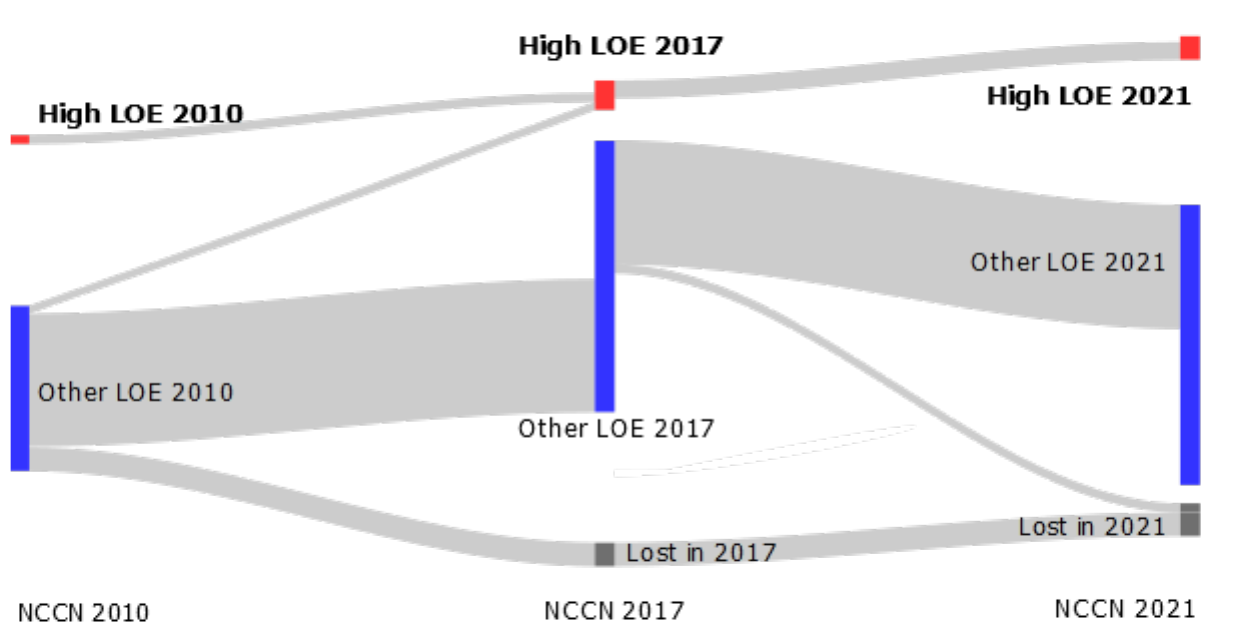
Figure 3. Evolution of evidence at the recommendation level in current and prior NCCN guidelines. LOE: level of evidence. “Lost in”: some recommendations were not repeated in newest versions of NCCN guidelines; “Other LOE” represents all other levels of evidence (see Section 2).